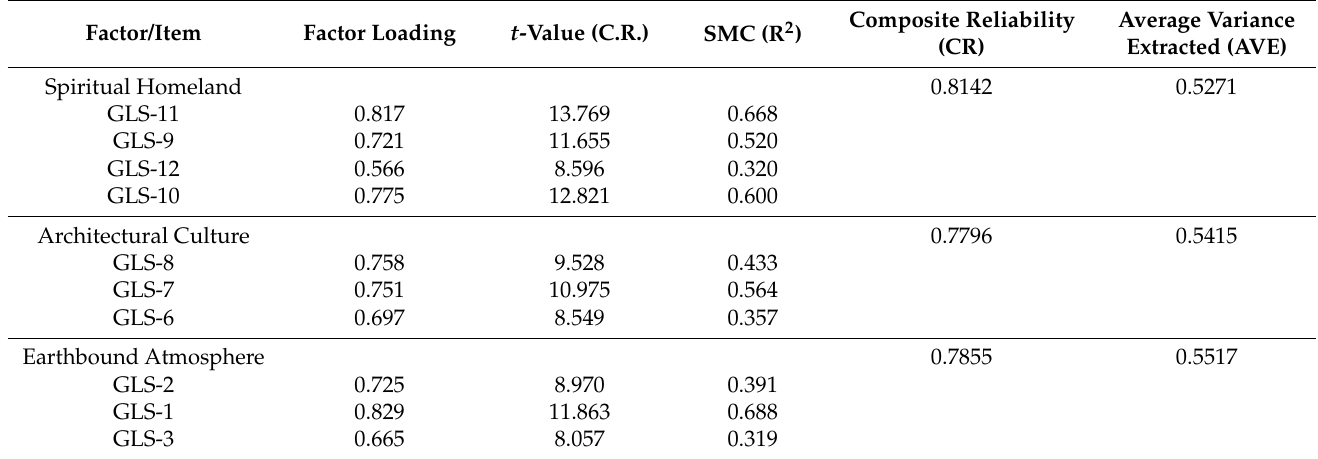
Table 5. Confirmatory factor analysis results (Sample 2, n = 228).